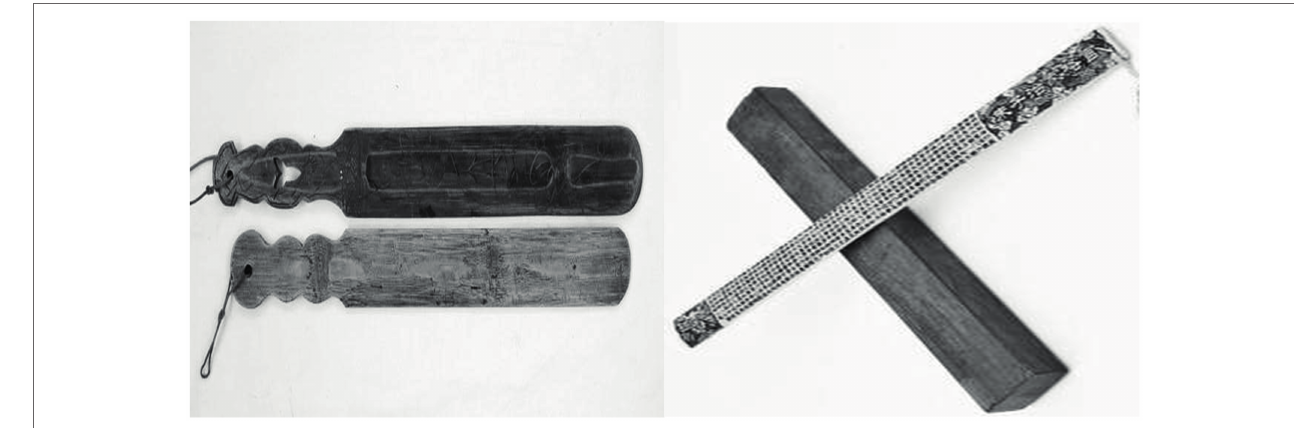
FIGURE 1 | Example of a ruler.